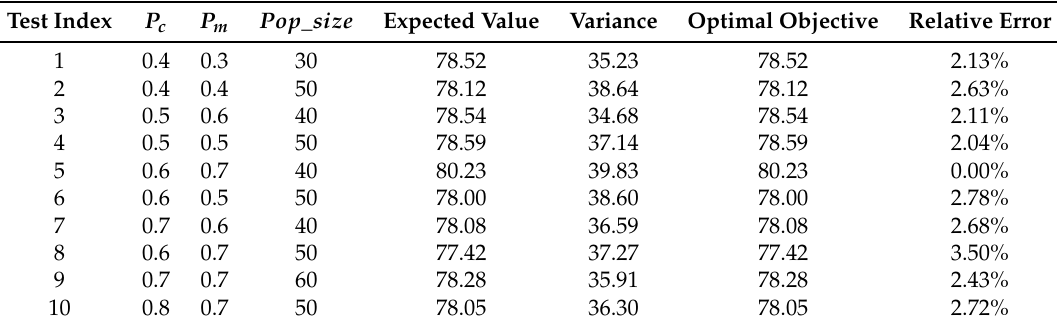
Table 3. The computational results with different parameters.